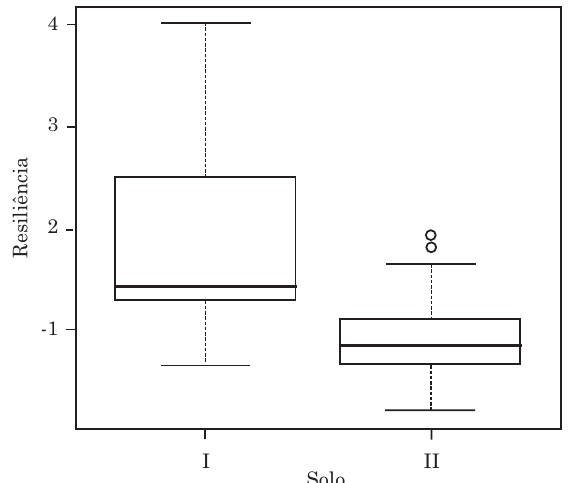
Figura 9. Distribuição dos valores de resiliência da permeabilidade do solo ao ar de dois Latossolos Vermelhos distróficos, um argiloso (I) e um franco-argilo-arenoso (II). As barras representam o intervalo de confiança da média (85